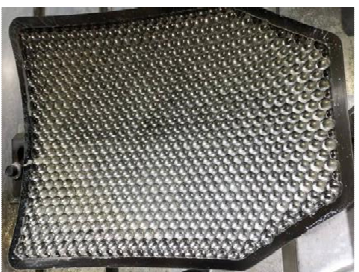
Figure 4. Upper die of the honeycomb ceramic slab with a multi-curved surface.